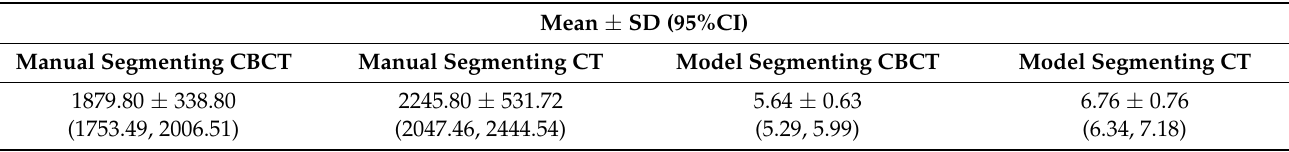
Table 4. The average time (seconds, s) cost of segmentation on one case.